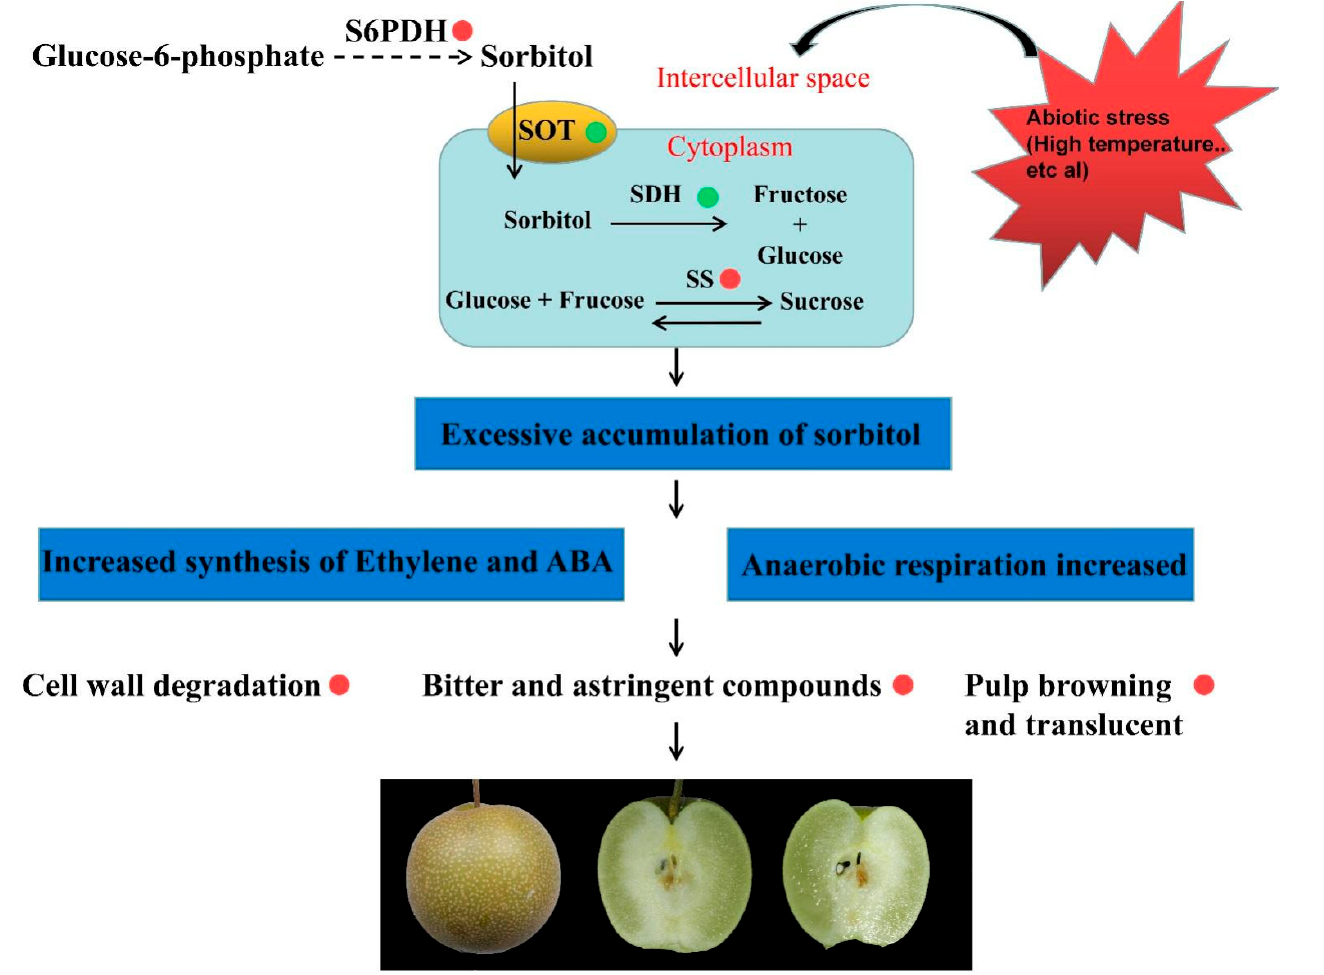
Figure 6. A proposed model of watercore negatively influencing pear fruit quality. The red and green circles refer to promoting and inhibiting related gene expression or metabolic pathways, respectively.